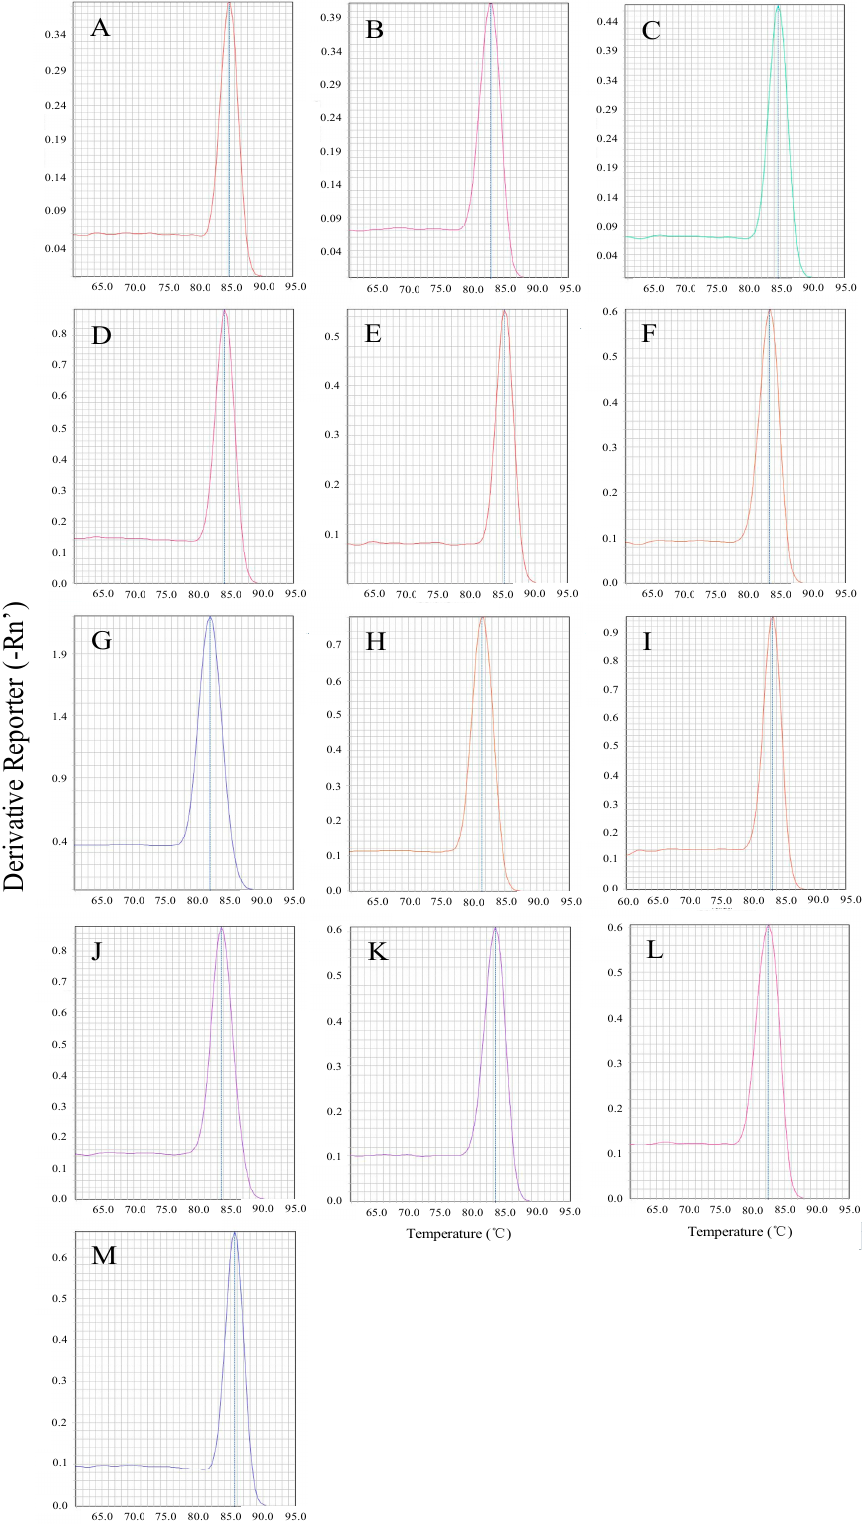
Figure 1. Melting curve analysis of quantitative real-time PCR (qRT-PCR) amplification (using gene-specific primers) of 12 housekeeping gene and a target gene in B. odoriphaga : ( A ) ACTb ; ( B ) EF1a ; ( C ) GAPDH ; ( D ) RPL18 ; ( E ) RPL28 ; ( F ) RPS15 ; ( G ) RPS18 ; ( H ) RSP5 ; ( I ) RPS13 ; ( J ) SDHA ; ( K ) TUB ; ( L ) UBCE ; and ( M ) HSP23 .